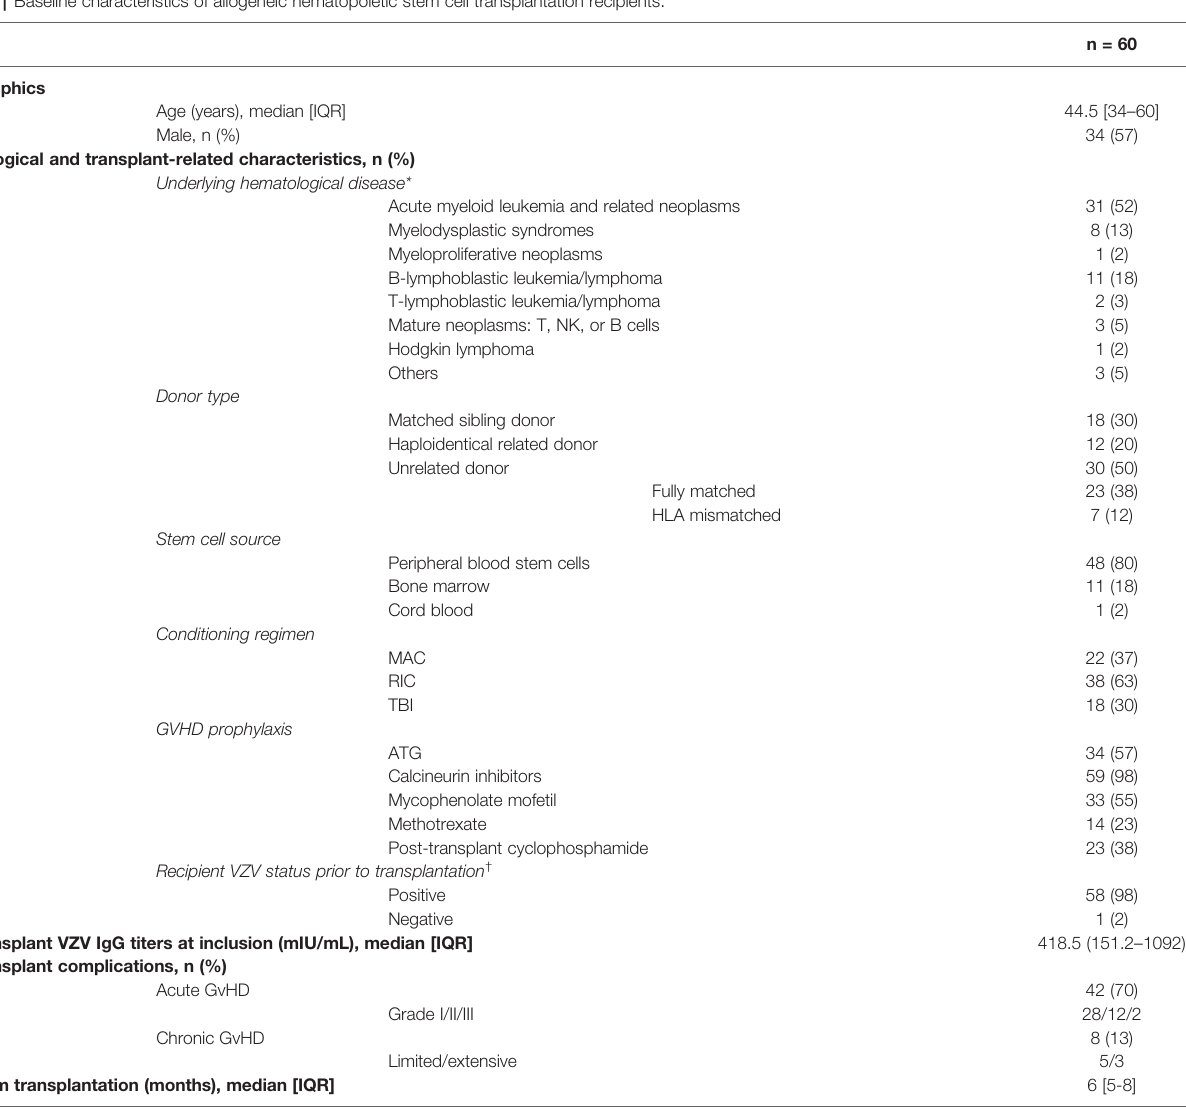
TABLE 1 | Baseline characteristics of allogeneic hematopoietic stem cell transplantation